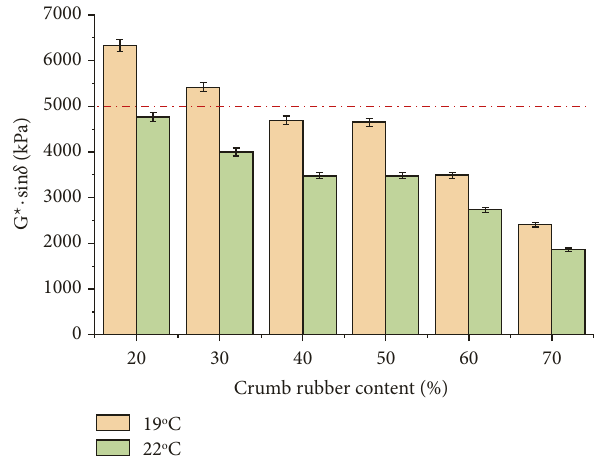
Figure 14: Fatigue factor of six CRMAs at different temperatures. Table 7: PG grade test results of PAV-aged